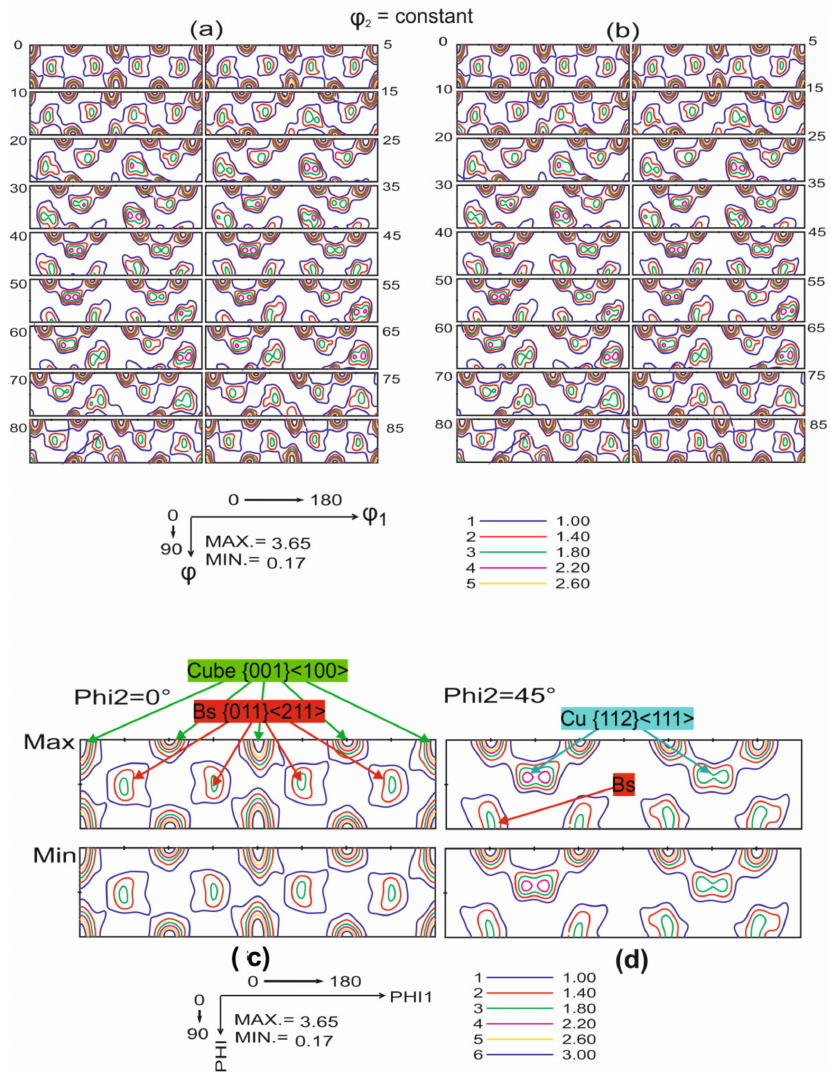
Figure 5. The ODF cuts of the as-received tube at ( a ) max and ( b ) min positions for different ϕ 2 angles. The ( c ) 0 ◦ and ( d ) 45 ◦ ODF sections showing the detected components, reprinted with permission from [18]. 2019,